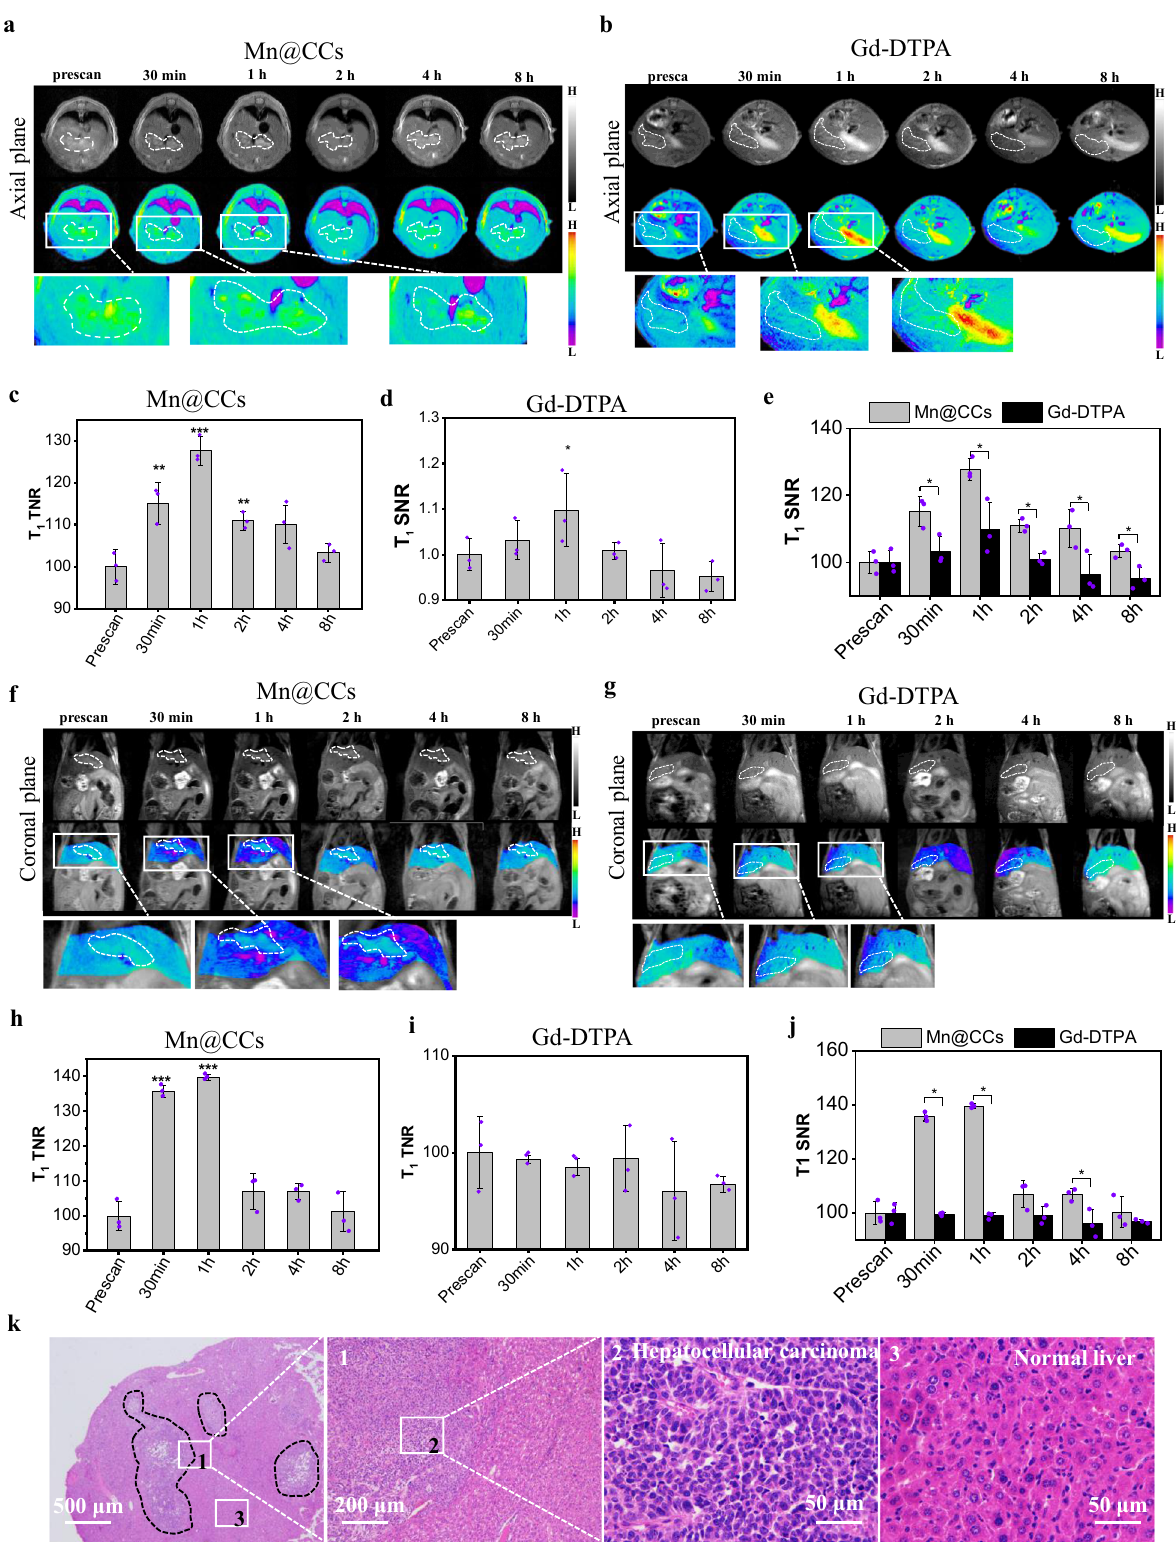
4 h post-injection through renal clearance with minor deposi- tion. Collectively, the superior relaxivity and imaging ability of ultrasmall orthotopic brain and liver tumors could conclude that Mn@CCs are superior to the current clinical MRI contrast agents for orthotopic tumors and provide more reliable early-stage